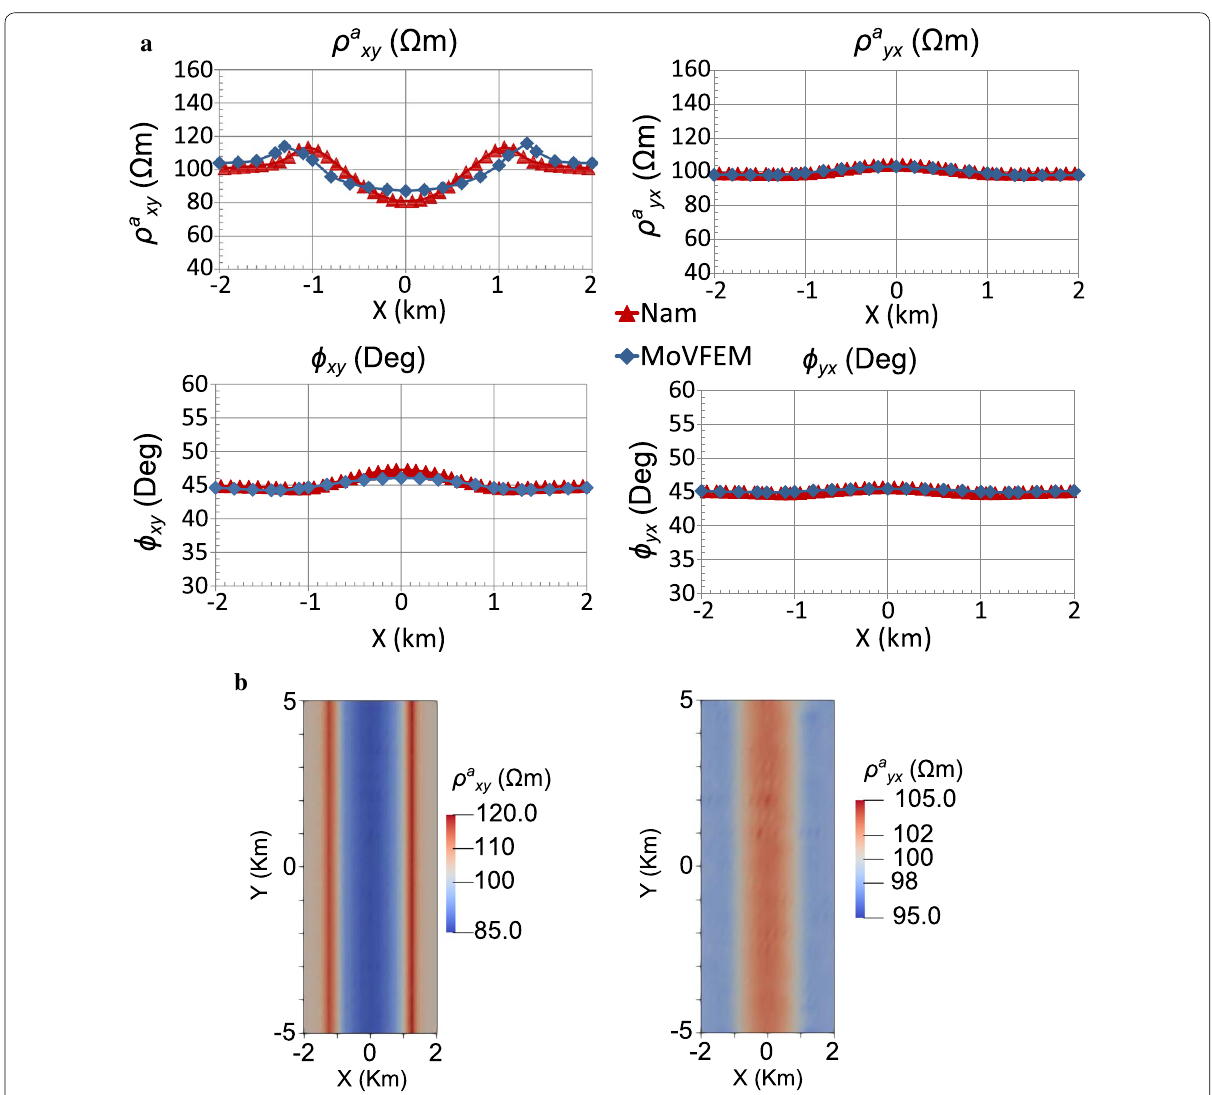
Fig. 12 Modeled MT responses from the homogeneous model with 2D topography apparent resistivity and phase angles for a signal of 10 Hz. a Response curves of xy ‑(left) and yx ‑(right) polarizations. Values are taken at the model surface along the profile y ≡ 0 . Values for MoVFEM and a reference models are displayed. b Map view of apparent resistivities at the model surface for xy ‑(left) and yx ‑polarization